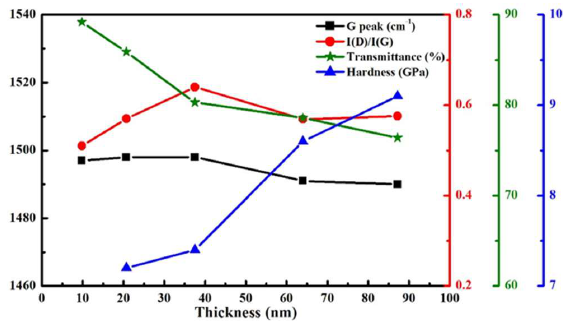
Figure 8. The analysis of DLC properties and transmittance in the different thickness of SiO x :DLC films. (RF bias = 400 V, DC power = 50 W, CH 4 = 12.5 sccm, HMDSO = 0.9 sccm).